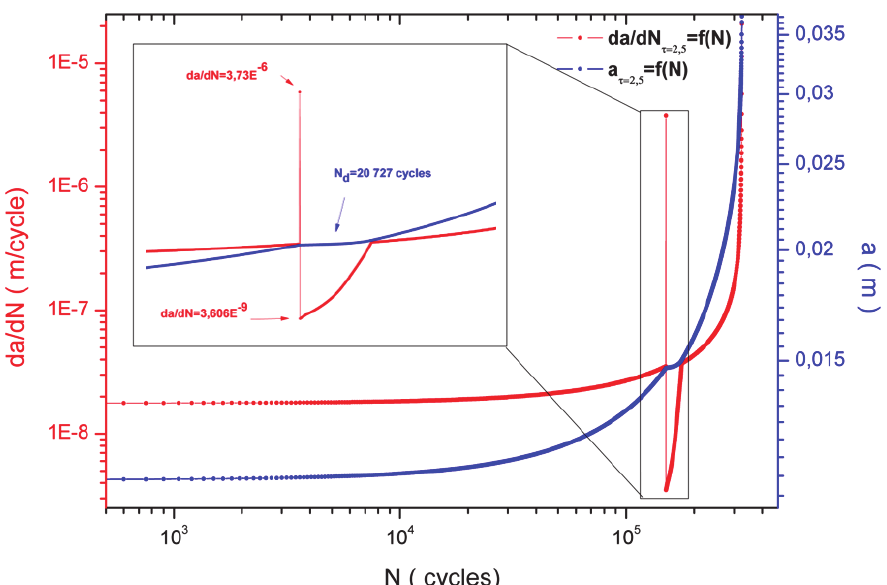
Figure 6: Evolution of the cracking rate and crack propagation as a function of the number of cycles for an overload rate ( τ = 2.5).